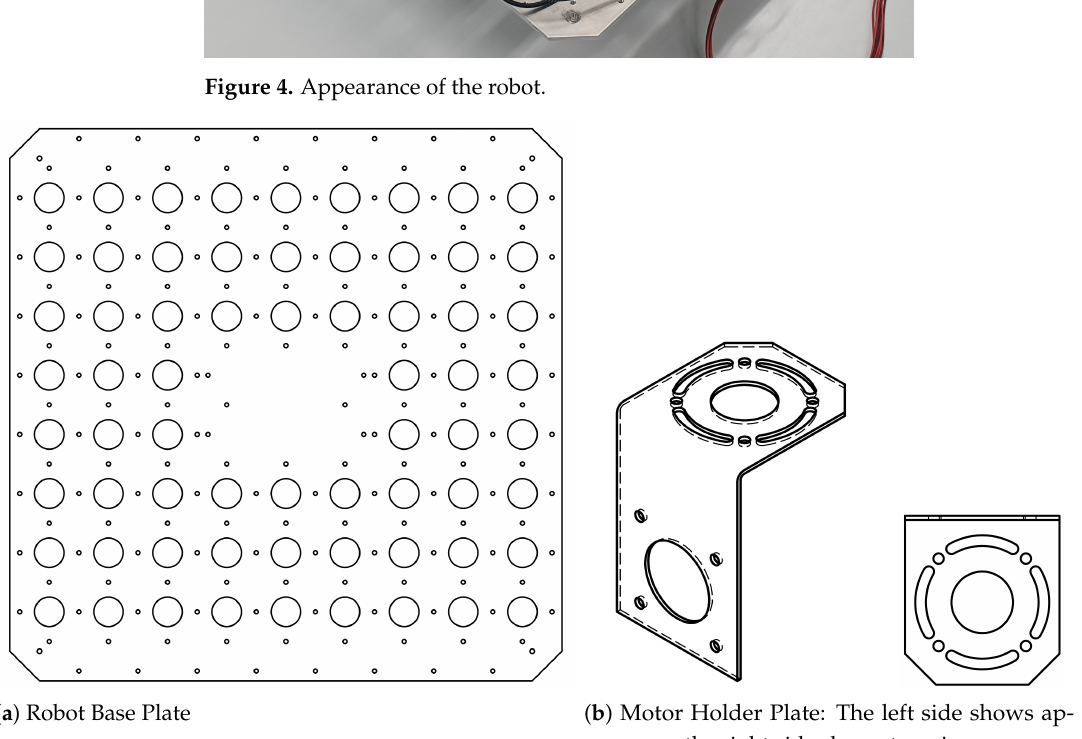
Figure 5. Appearance of the robot’s parts: ( a ) shows the board that serves as the foundation. ( b ) shows the plate to hold the